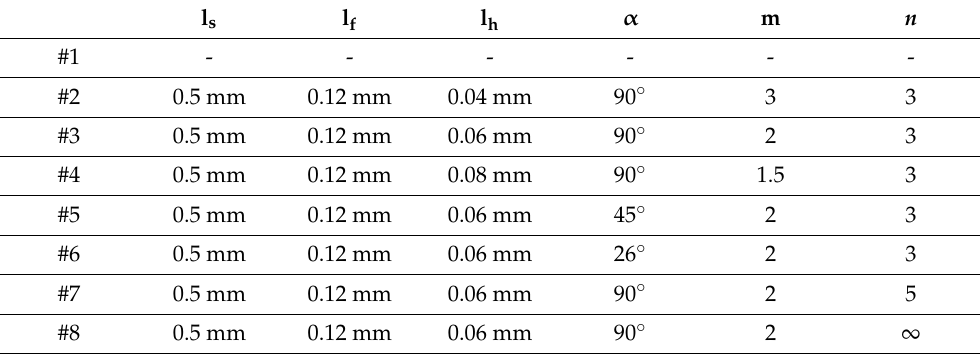
Table 1. Geometrical parameters of the